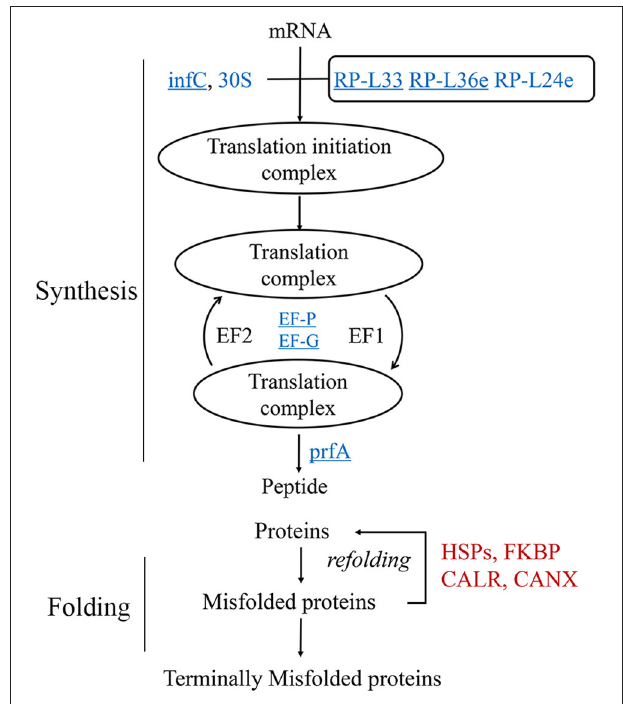
FIGURE 3 | Regulation of protein synthesis and turn over activity. Protein names in blue were decreased, while red ones were increased. The underlined proteins were present in the enriched “translation” biological process in Figure 2B . 30S, 30S ribosomal protein; infC, translation initiation factor IF-3; EF-G, elongation factor G; EF-P, elongation factor P; RP-L, large subunit ribosomal protein; prfA, peptide chain release factor 1; CALR, calreticulin; CANX, calnexin; FKBP, FK506-binding